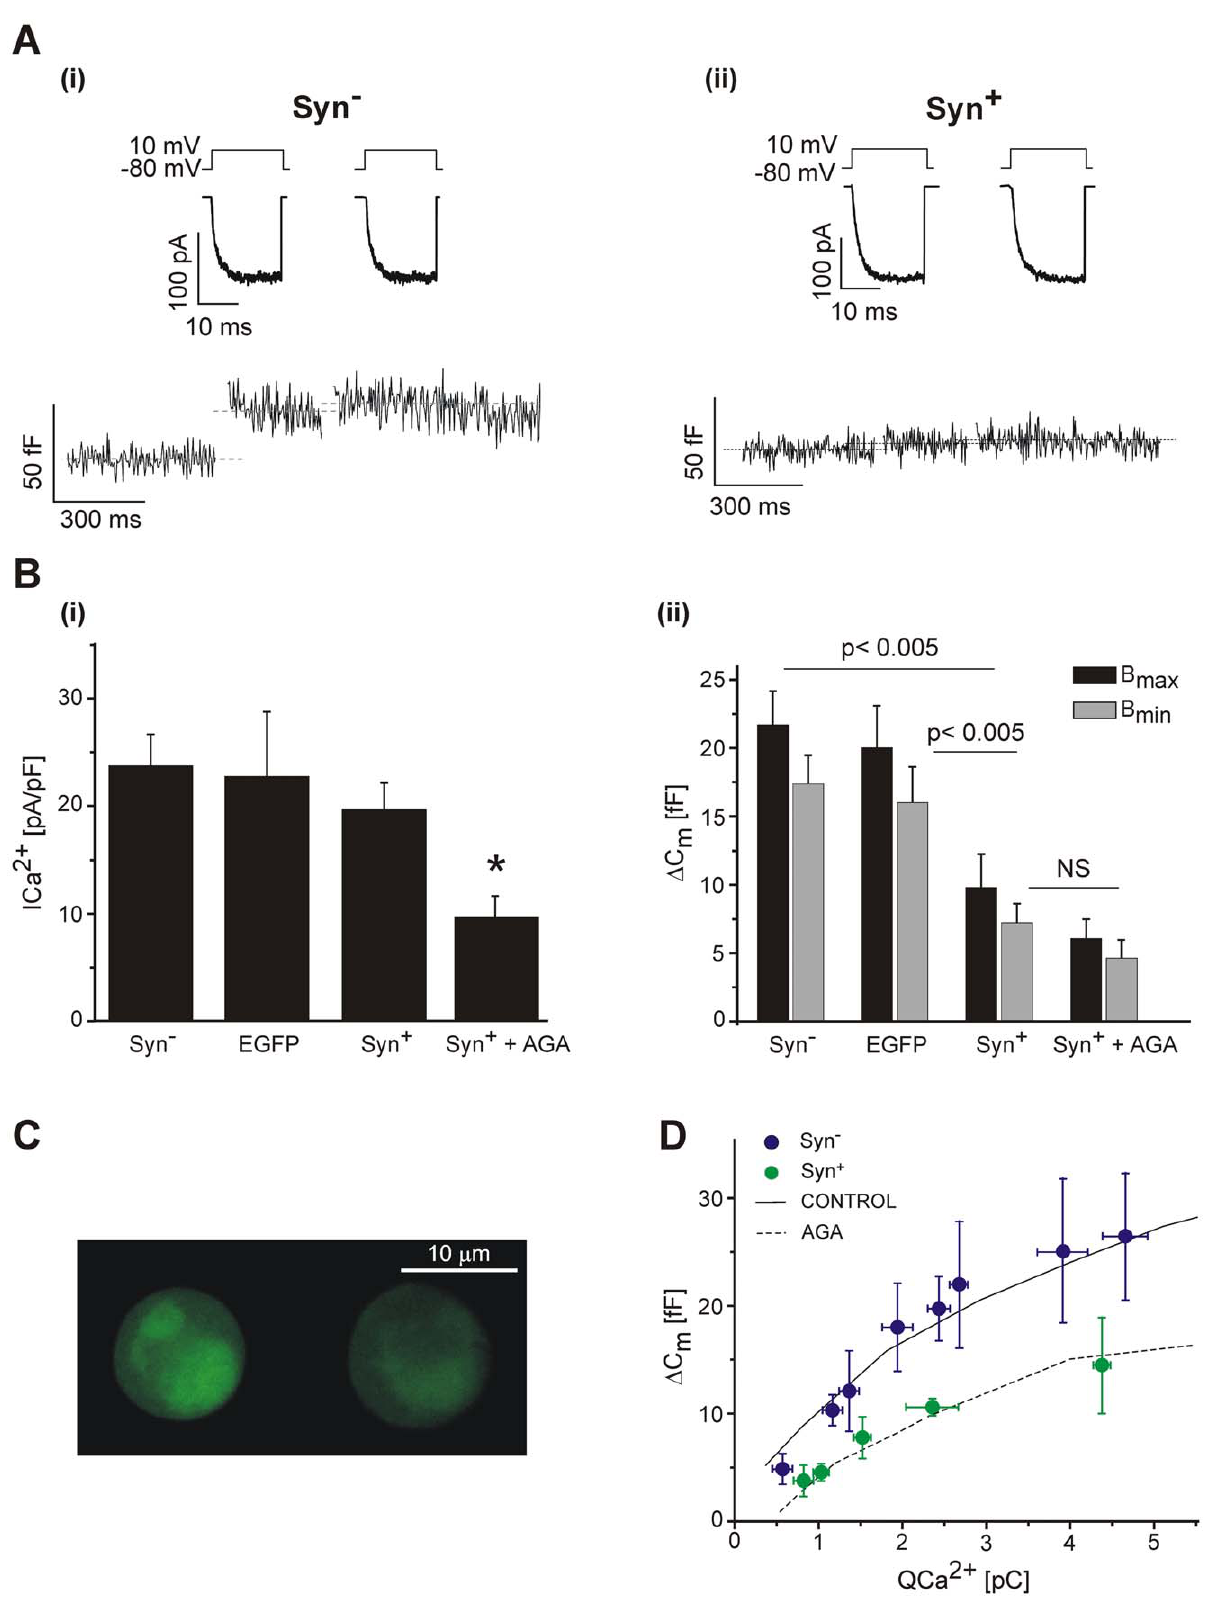
Figure 3. Synprint mediates the coupling of IRP with P/Q-type calcium channels. A: Examples of original records of Ca 2 + currents (top) and membrane capacitance changes (bottom) in response to the application of the dual 10 ms pulse protocol, in Syn 2 (i) or Syn + (ii) cells. B. (i) Calcium current densities obtained in Syn 2 (n=30), EGFP (n=7), Syn + (n=14), and Syn + cells treated with 200 nM v -agatoxin-IVA (Syn + + AGA) (n=10). (ii)